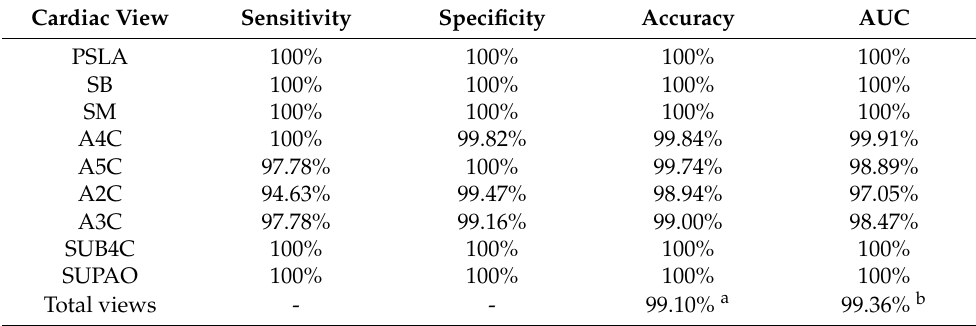
Table 5. Test results of the presented method on Dataset